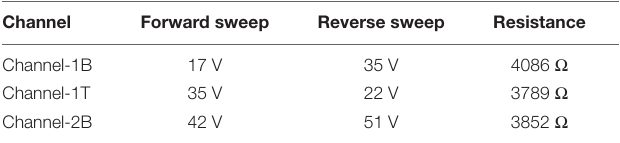
drain voltage, showing the channels are Ohmic as shown in the inset of Figure 5 . Back-gated measurements were also performed to obtain the I D –V G curve with a forward and reverse voltage sweep from − 100 to +100 V, with a fixed drain voltage of 50 mV, Figure 5 (main panel). Data analysis was performed using the SCRAMBLE software which was developed in-house and graphs were plotted in Originlab. The I D –V G curves show the Dirac curve of the graphene channels, revealing that the three channels are hole doped. From the curves, the carrier mobility of the three channels is found to be around 500–600 cm 2 / Vs (Zhong et al., 2015; Bøggild et al., 2017). Table 1 shows the Dirac point voltages (forward and reverse) and resistances for all three